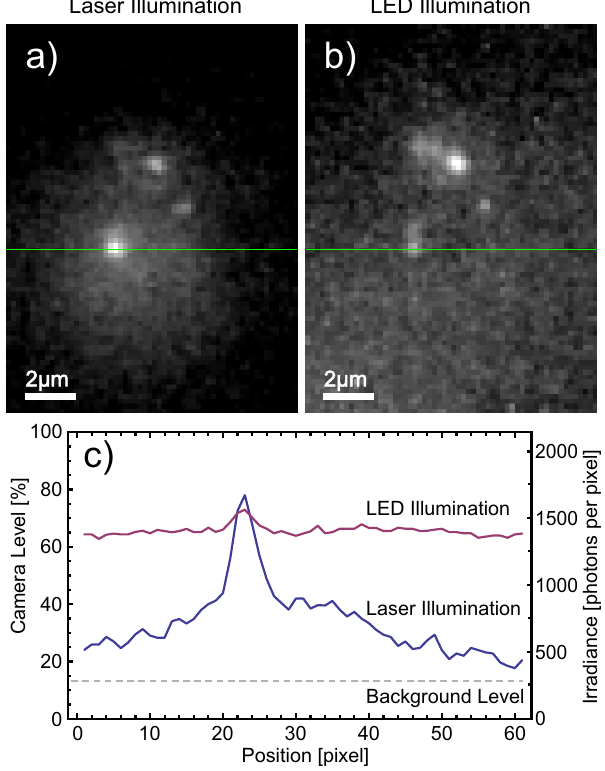
Figure 5. Direct comparison of two wide-field images acquired by laser (a) and LED illumination (b) . The gray levels of the images have been adapted to account for the increased background with the LED illumination. Still the slightly weaker signal to noise ratio is obvious. To have a direct comparison the camera levels are presented uncorrected in figure (c) . The background level of the camera is at 13% (blocking the excitation light) and should be subtracted for both illuminations. Light leakage through the filters increases the LED illumination background level to more than